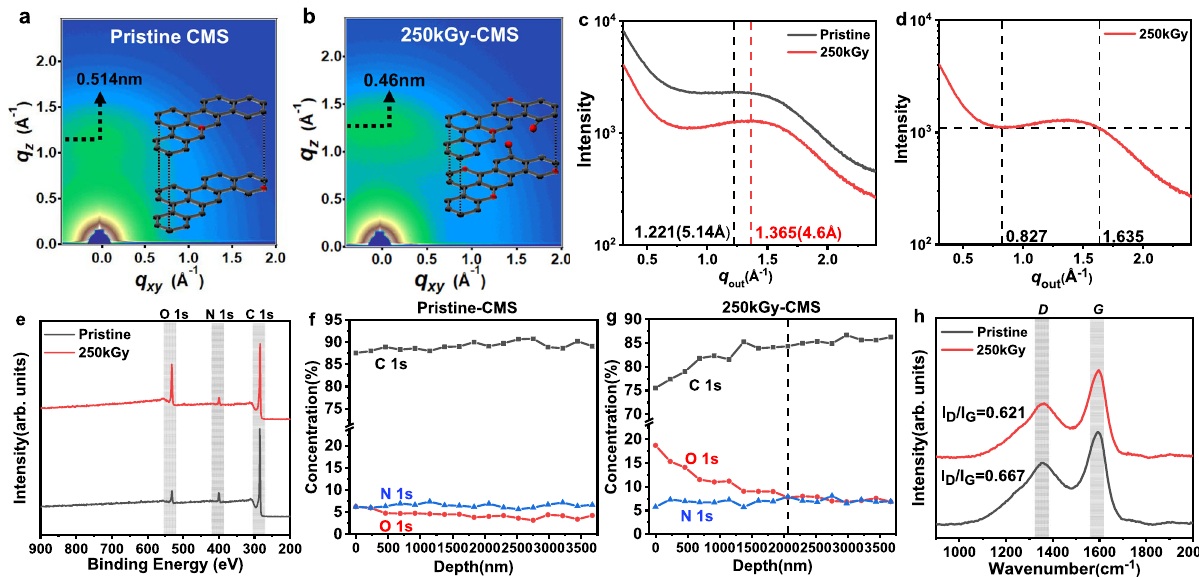
Fig. 2 | Structure characterization of the pristine and electron-irradiated CMS fi lms.a , b 2D-Grazing incidencewideangleX-ray scattering (GI-WAXS)patterns of 500°C pristine- and 250kGy-CMS. c 1D-GI-WAXS spectra of the pristine- and 250kGy-CMSalongtheout-of-planeaxis. d 1D-GI-WAXSspectraofthe250kGy-CMS withabroadpeakhighlightedbyadashedline. e X-rayphotoelectronspectroscopy